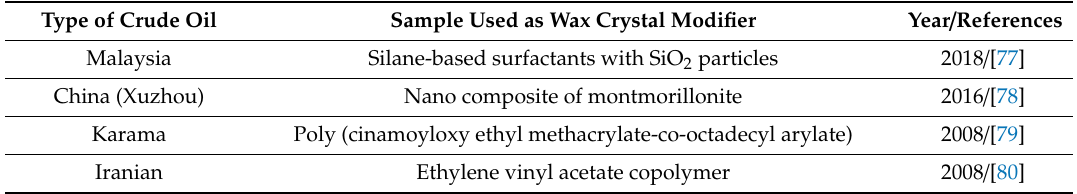
Table 4. Examples of wax crystal modifier used in was deposition